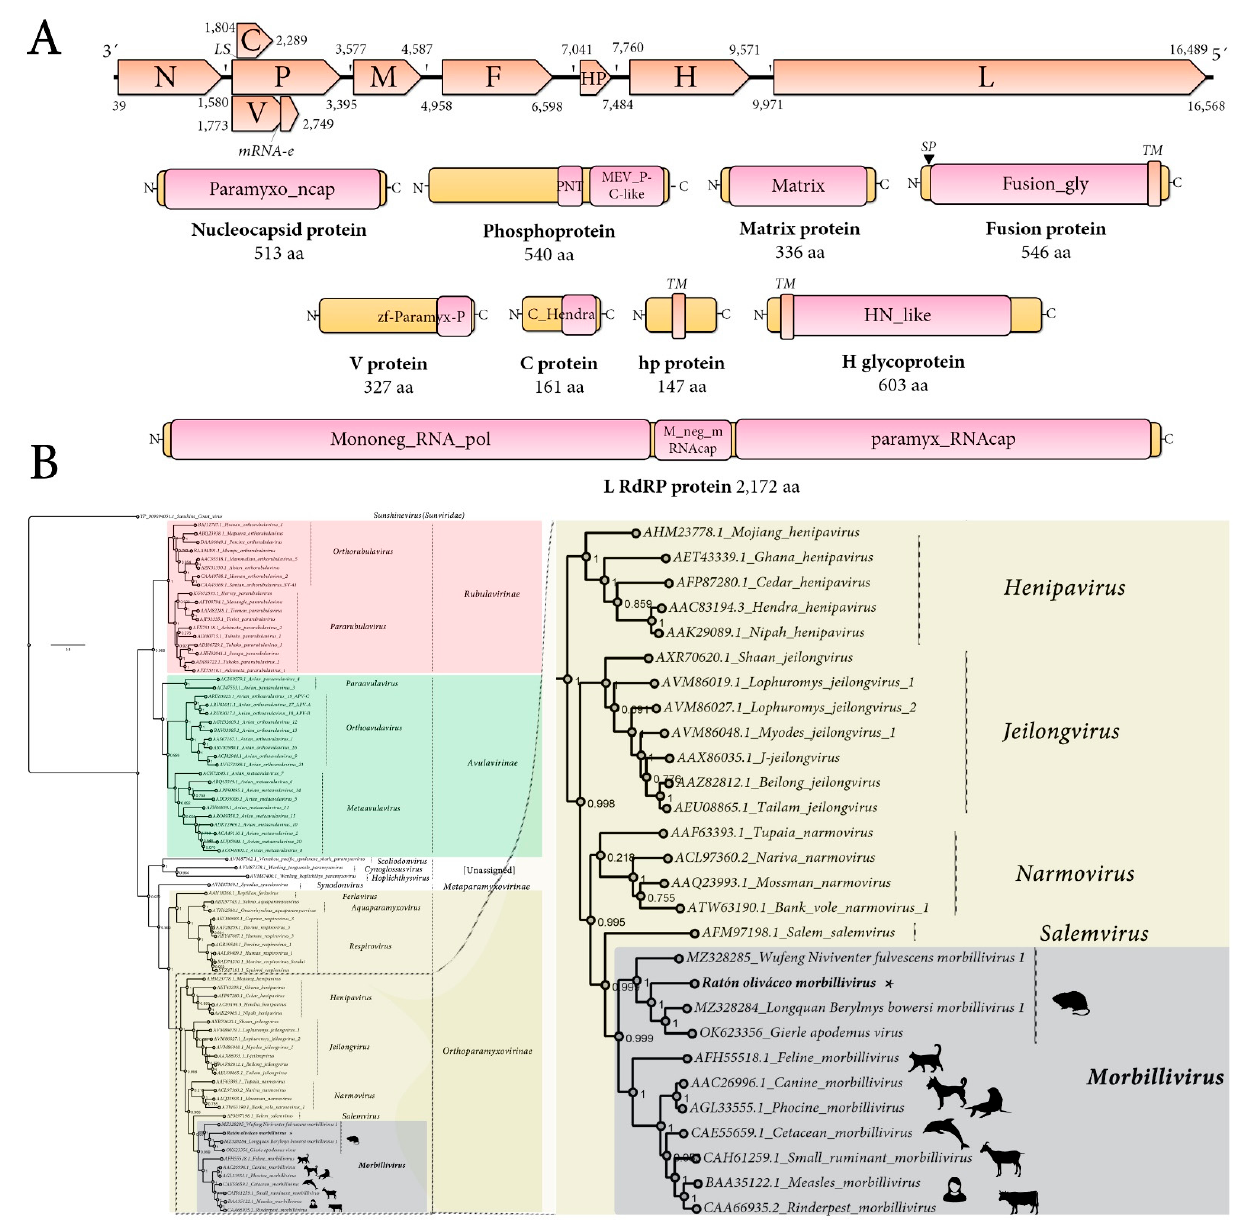
Figure 1. Genomic architecture and phylogenetic insights of Ratónoliváceo morbillivirus. ( A ) Genome graphs depicting architecture and predicted gene products of RoMV. The predicted coding sequences are shown in orange arrow rectangles; start and end coordinates are indicated. Gene products are depicted in curved yellow rectangles and size in aa and name are indicated below. Predicted domains or HHPred best-hit regions are shown in curved pink rectangles. Abbreviations: N, nucleoprotein CDS; P, phosphoprotein CDS; M, Matrix protein CDS; F, Fusion protein CDS; HP, hypothetical protein CDS; H, Hemagglutinin glycoprotein CDS; L, RNA-dependent RNA-polymerase CDS; TM, trans-membrane domain; SP, signal peptide; LS, leaky scanning; mRNA-e, RNA editing. Domain abbreviations are described in the main text. ( B ) Maximum likelihood phylogenetic tree based on amino acid alignments of the L polymerase of RoMV and members of accepted species within family Paramyxoviridae . The right panel represents an inset of the complete phylogenetic tree that is available as Supplementary Figure S9. The tree is rooted at Sunshine coast virus (family Sunviridae ). The scale bar indicates the number of substitutions per site. Node labels indicate FastTree support values. Silhouettes represent natural hosts. Genbank accession numbers of the proteins used are depicted before each virus species name. * indicates